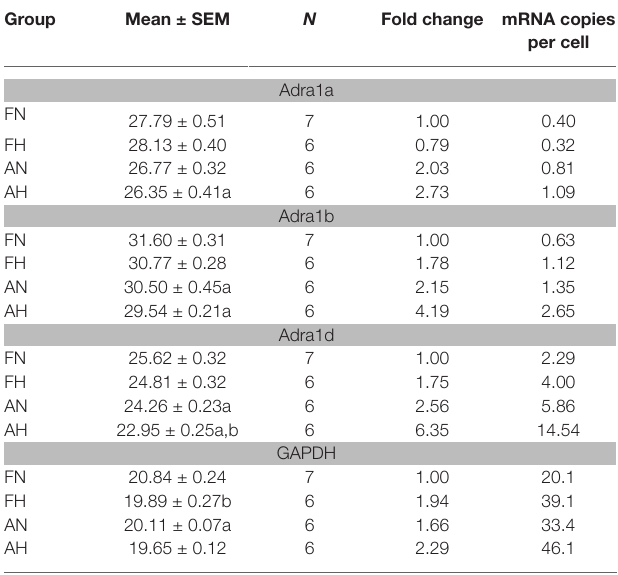
TABLE 1 | Chronic hypoxia, maturation and adrenergic receptor and GAPDH mRNA expression. Group Mean ±